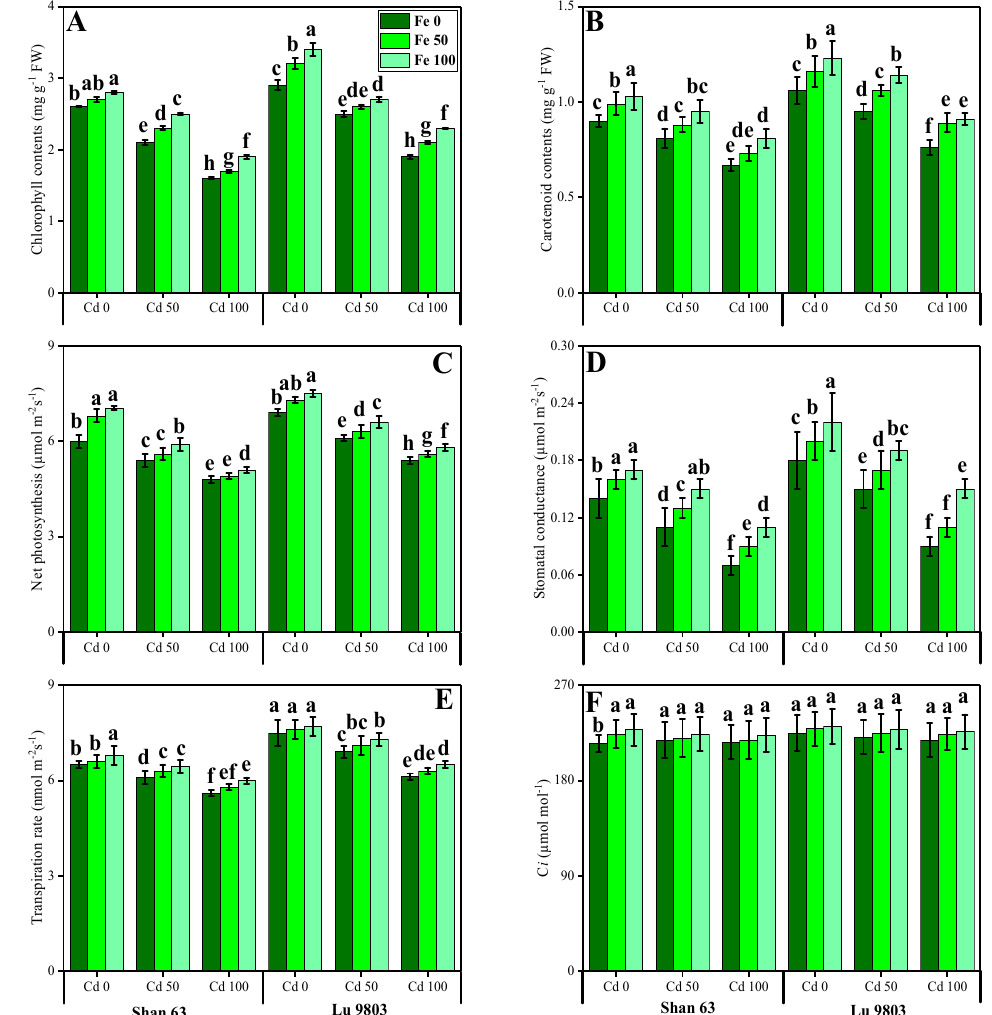
Figure 2. Effect of different concentrations of exogenous application of FeSO 4 (0, 50, and 100 µM) on photosynthetic pigments and gaseous exchange attributes, i.e., total chlorophyll contents ( A ), carotenoid contents ( B ), net photosynthesis ( C ) stomatal conductance ( D ), transpiration rate ( E ) and intercellular CO 2 ( F ) of Oryza sativa (cultivars) grown under different levels of Cd stress (0, 50 and 100 µM). Bars sharing different letter(s) for each parameter are significantly different from each other according to Duncan’s multiple range test ( p < 0.05). All the data represented are the average of four replications ( n = 4). Error bars represent the standard deviation (SD) of four replicates.